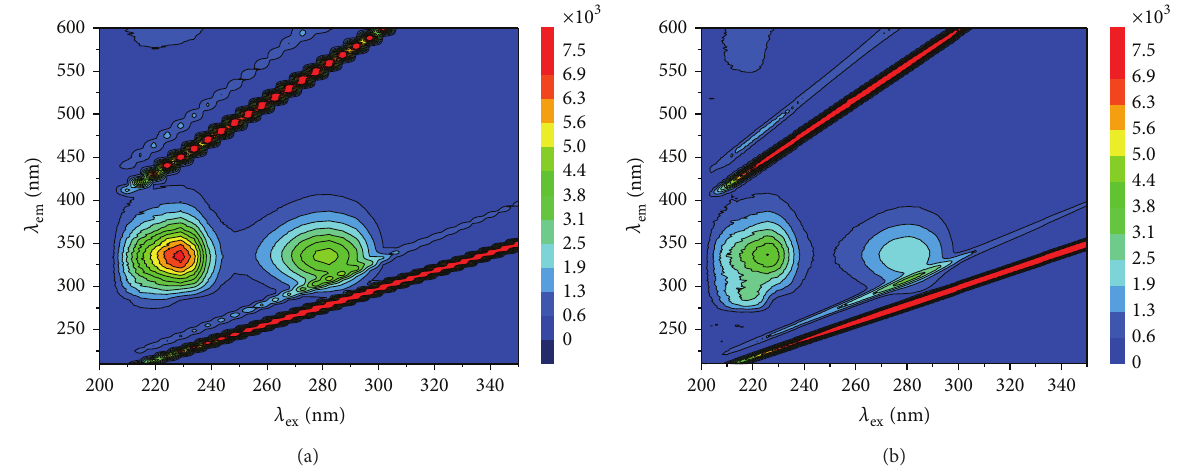
Figure 9: Contour fluorescence intensity spectra of BSA (a) and EVG-BSA system (b).